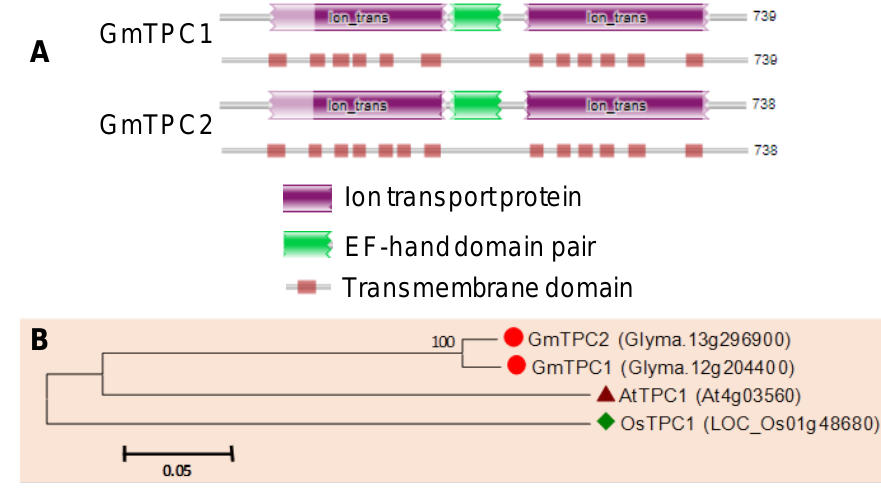
Figure 8. Schematic representation of functional domains of soybean two-pore channel (TPC) family proteins ( A ). Unrooted phylogenetic tree of the TPC family proteins from soybean ( Glycine max ), rice ( Oryza sativa ), and Arabidopsis thaliana ( B ). Soybean TPCs are marked with red circles, Arabidopsis TPC1 was marked with purple triangles, while rice TPC1 were marked with green diamonds. The bar indicates the relative divergence of the sequences examined, and bootstrap values are displayed next to the branch.